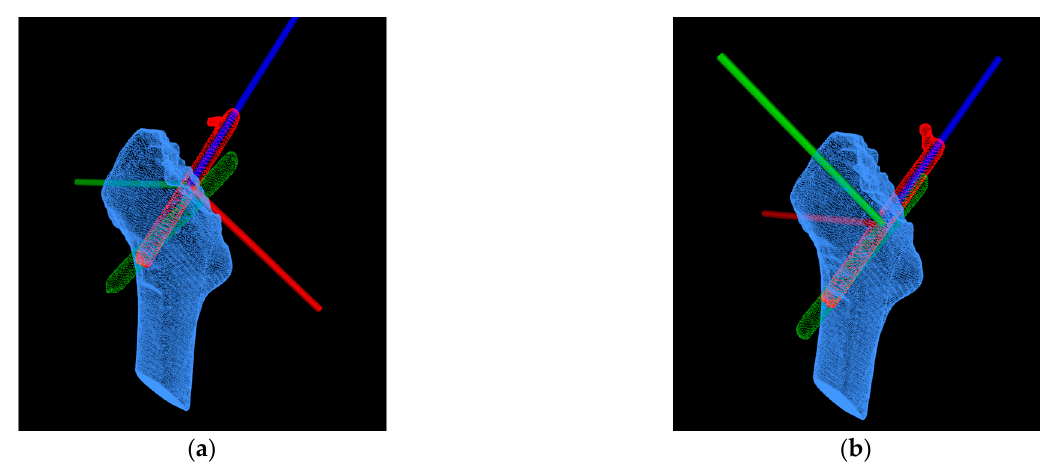
Figure 14. Converting the aligned point cloud data to the new coordinate system: ( a ) the coordinate system of the proximal pin; ( b ) the coordinate system of the distal pin.